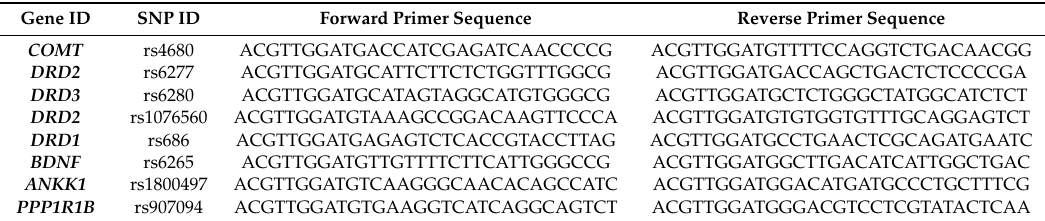
Table A2. Primer